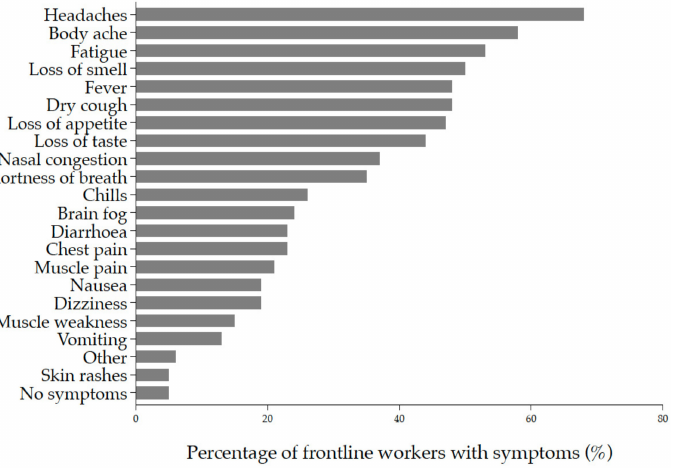
Figure 4. Acute COVID-19 symptoms were reported at the time of diagnosis ( n = 62). Each symptom is ordered from top to bottom by increasing frequency of occurrence. The bars represent the proportion of workers with